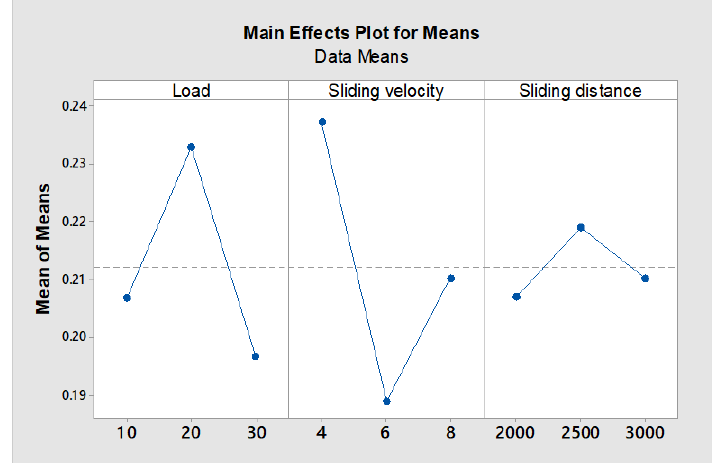
Fig. 3. Main effects plot for grey relational